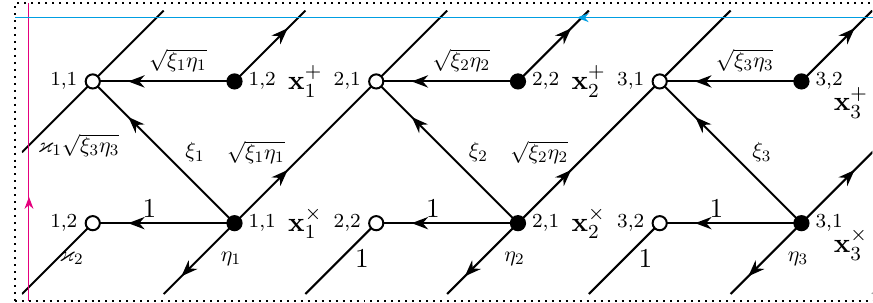
Figure 4 . Extended and deformed bipartite graph for the Toda